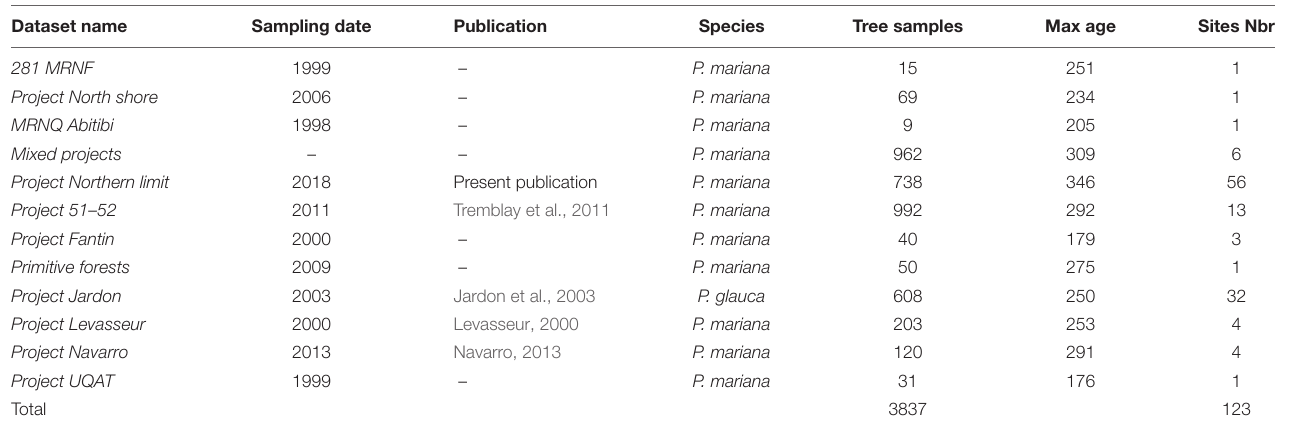
TABLE 1 | Datasets compiled for this